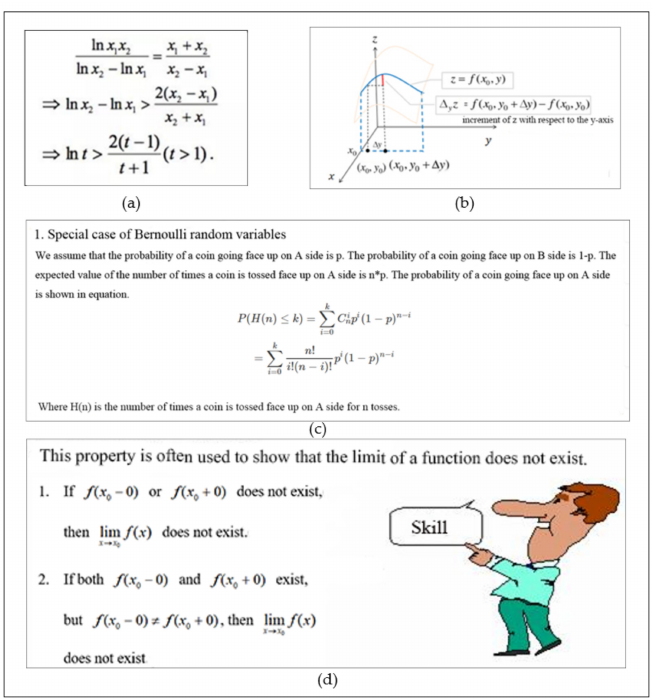
Figure 4. Examples of images. Figure ( a ) contains only mathematical formulas. Figure ( b ) con- tains coordinate axes, formulas, and text. Figure ( c ) contains mathematical formulas and text. Figure ( d ) contains formulas, text and other